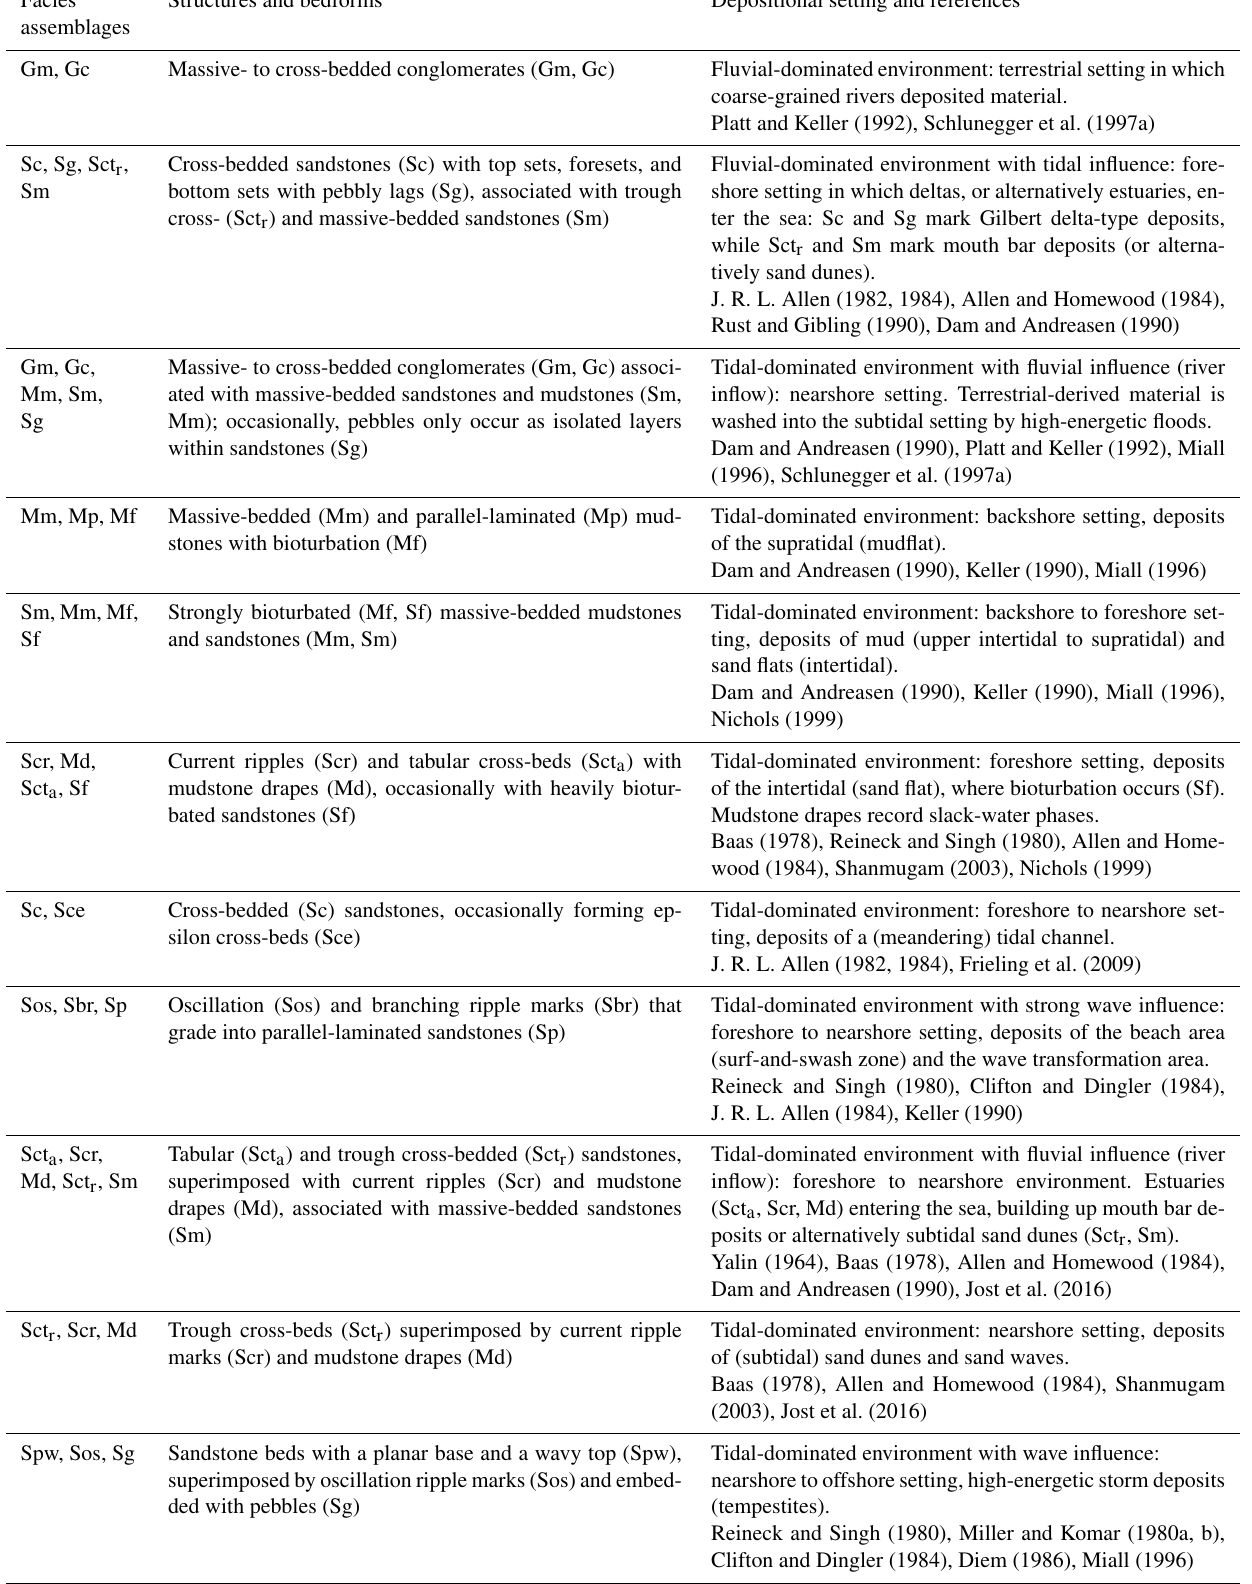
Table 3. Lithofacies encountered in the Sense section.